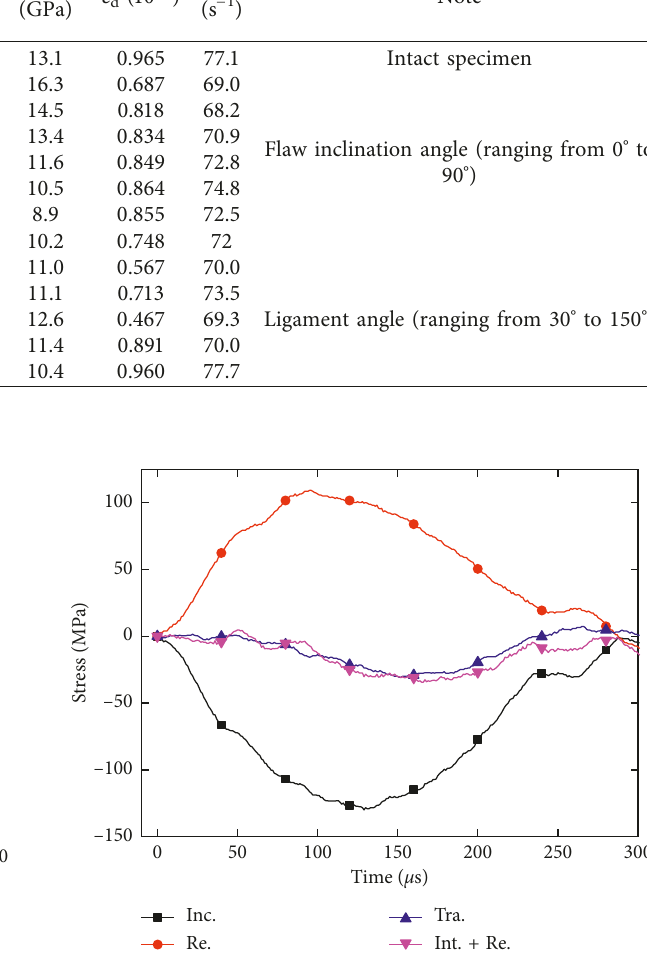
Figure 4: Stress equilibrium of the sandstone specimen S-60-0 be- tween incident and transmitted bars.